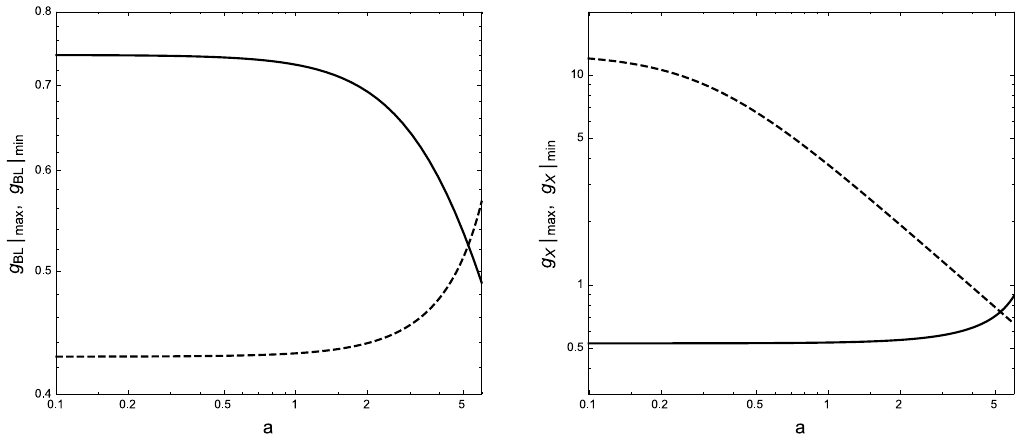
Figure 1 . Left panel : the solid and dashed lines depict the maximum and minimum values of g BL at µ = v R = 10 5 GeV, respectively, as a function of a . Right panel : the minimum and maximum values of g X as a function of a , which correspond to the maximum and minimum values of g BL shown in Left Panel.